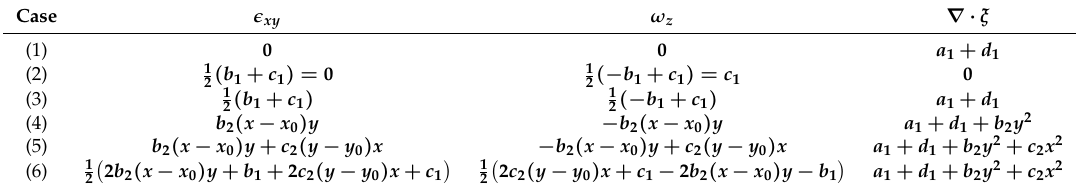
Table 2. u - and v -fringe shapes and corresponding shear, rotation and volume